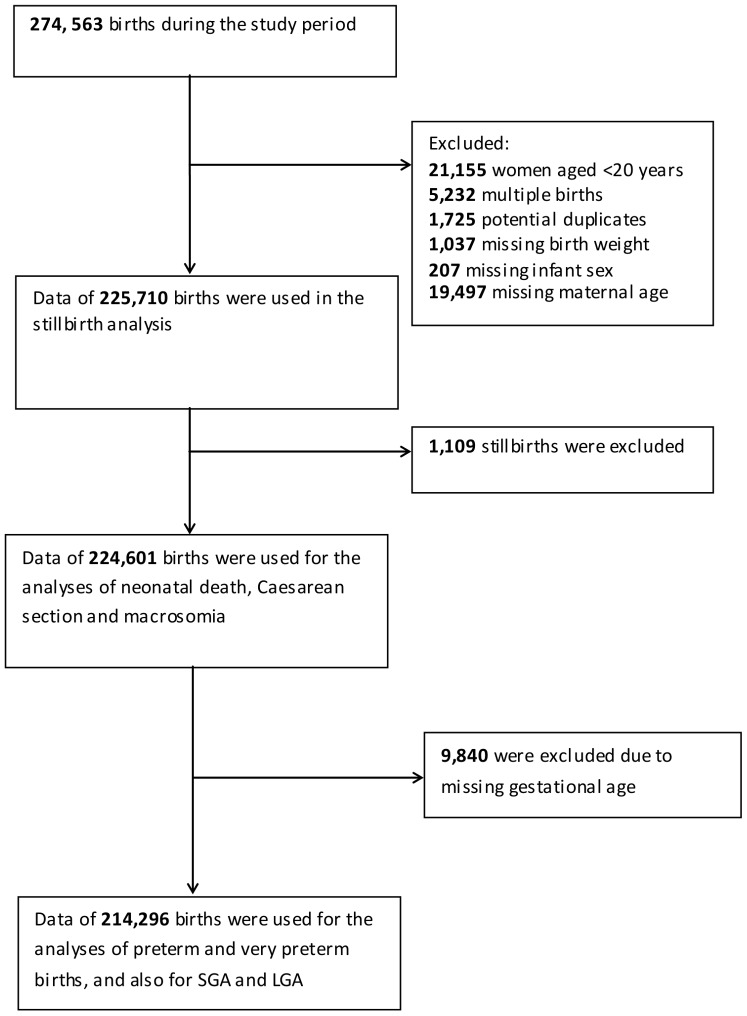
Number of births, inclusions and exclusions during the study period.